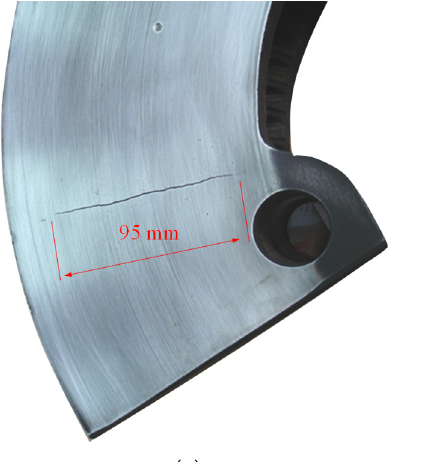
Figure 10. One-sided crack on the ring of the railway brake disc: ( a ) view of the crack and ( b ) the relationship between the length of the crack and its depth, measured with the RMG 4015 device.